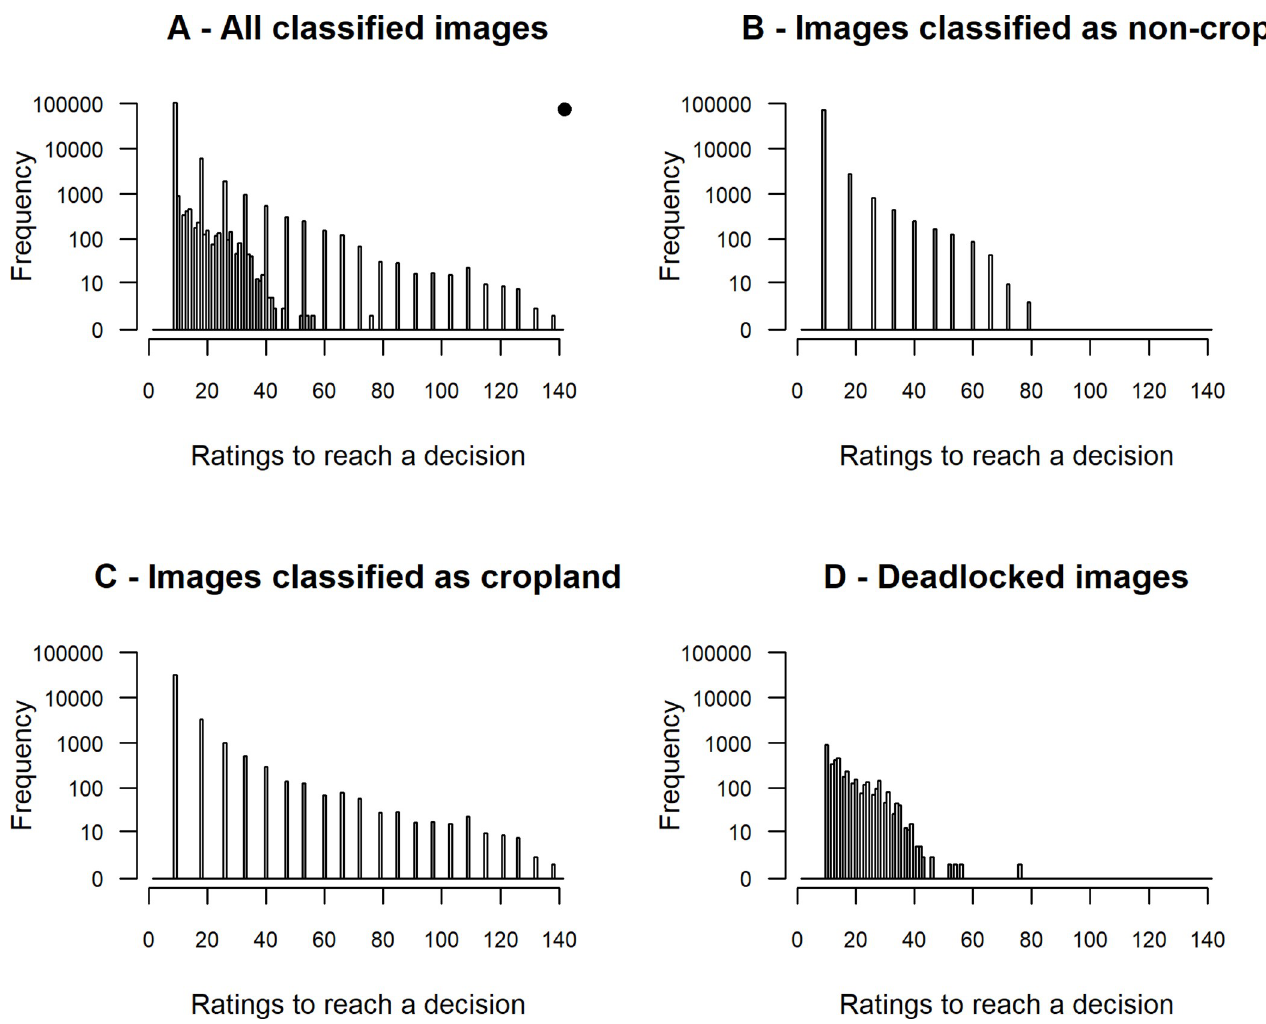
Fig 3. Distributions of the number of volunteer ratings required to draw a conclusion about the classification of the image. (A) all images combined, (B) images eventually classified as non-cropland, (C) images classified as cropland, and (D) images where the crowd showed no agreement. The logic of declaring an image concluded is laid out in the Theoretical Approach section. Note the modified log scale on the y-axes. The dot in the upper right corner of panel A shows how many images never reached a conclusive classification. The peaks seen in panels A-C is because the classification ratios are limited by the counts in each category necessarily being integers. So the first peak is the situation where there are no dissenting ratings, the second peak includes one dissent, and so